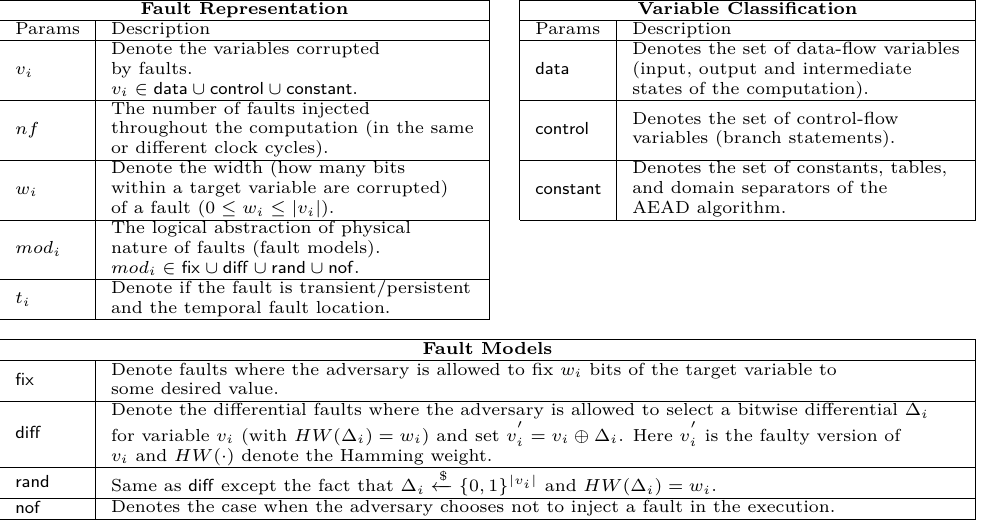
Table 1: Unified Representation of